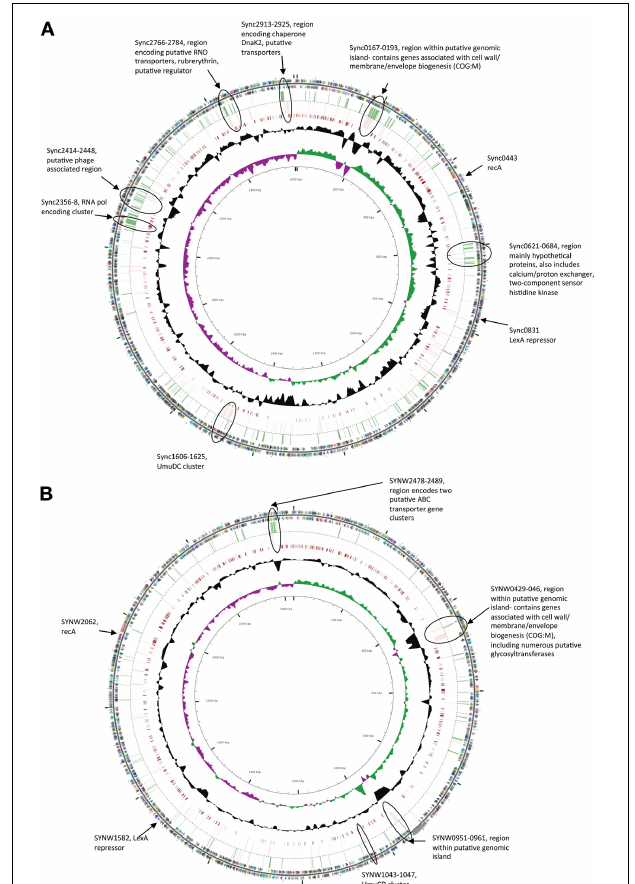
FIGURE 1 | Circular figures showing chromosomes of Synechococcus sp. CC9311 (A) and WH8102 (B) indicating location of genes strongly upregulated ( > 2 fold) by EB and MC treatments. Outermost two circles indicate positions of CDSs in plus (circle 1) and minus (circle 2) strands colored by functional category: translation, ribosomal structure, and biogenesis(pink); transcription (orange);DNA replication, recombination and repair (fuchsia); cell division and chromosome partitioning (yellow); posttranslational modification, protein turnover, chaperones (brown); cell wall/membrane/envelopebiogenesis (olive); cell motility and secretion (dark green); inorganic ion transport and metabolism (green); signal transduction mechanisms (blue/green); energy production and conversion (aqua); carbohydrate transport and metabolism (blue); amino acid transport and metabolism (teal); nucleotide transport and metabolism (turquoise); coenzyme metabolism (dark blue); lipid metabolism (lavender); secondary-metabolite biosynthesis, transport, and catabolism (purple); general function prediction only (light gray); function unknown (dark gray); and no COG (gray black). Genes whose expression was upregulated by more than 2 fold in microarray experiments when exposed to EB are indicated by green bars in the third circle, while those similarly upregulated by MC are indicted by pink bars in the fourth circle. Moving toward the center, the next circle map pairwise blastn alignments (expected threshold = 1e-20) between CC9311 and WH8102. Circle six shows G + C content (deviation from average), and the seventh circle illustrates G + C skew in green ( + ) and purple ( − ). The scale (in Kbp) is indicated on the innermost circle. Genes of particular interest are circled and